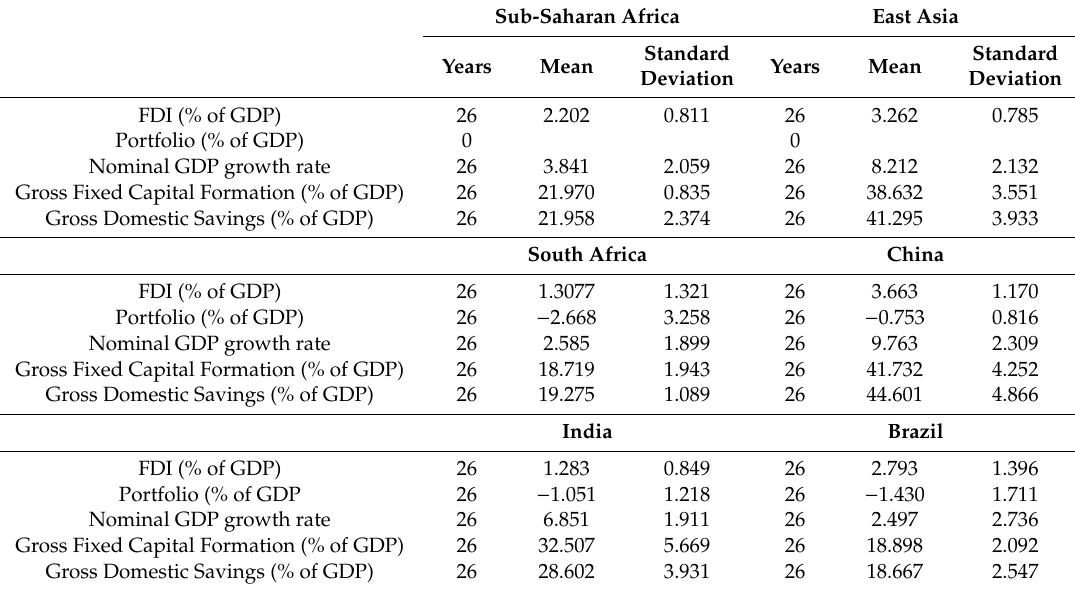
Table 2. Summary statistics (Years: